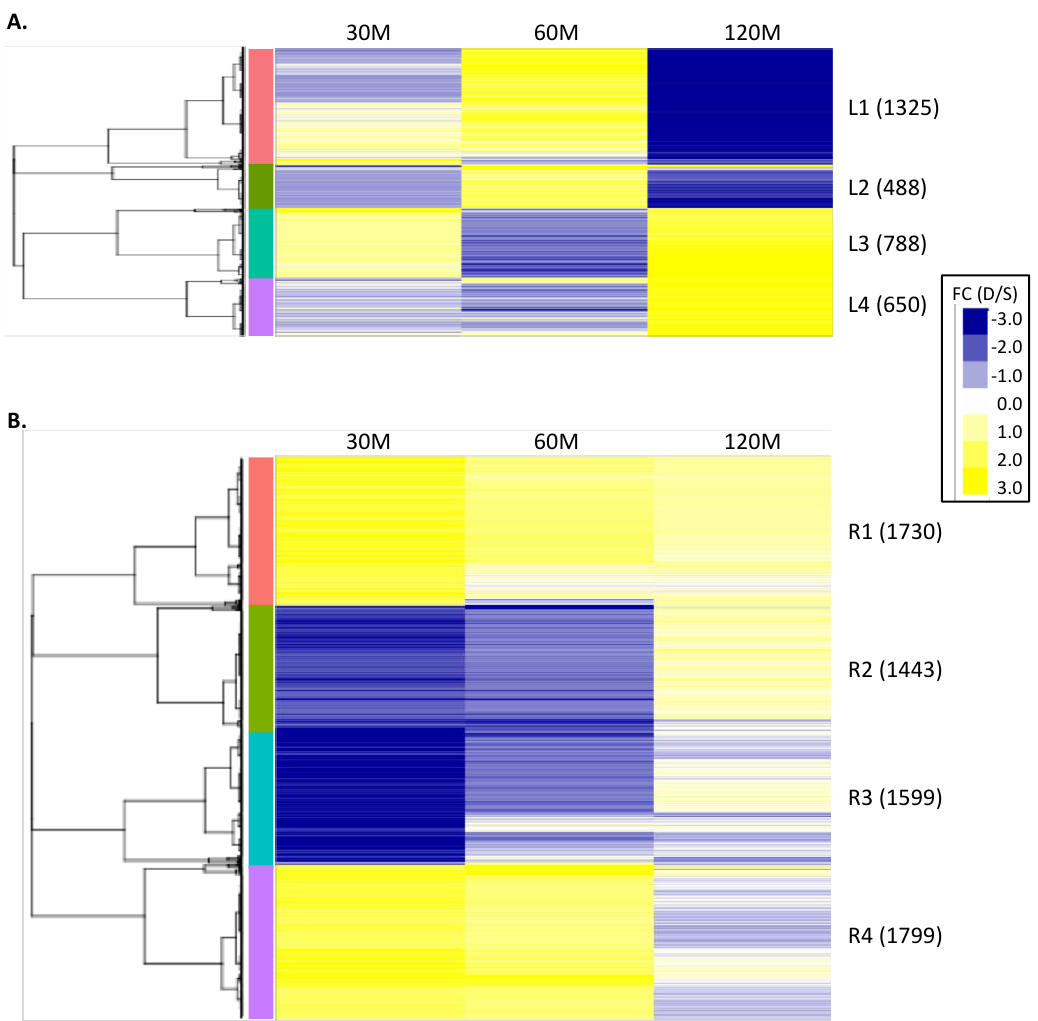
Figure 2. Iron stress responsive genes can be clustered by expression patterns across time. Hierarchical clustering of all fold change (FC) data was performed to characterize gene expression changes across time. Blue indicates repression and yellow indicates induction, in response to iron stress (deficient conditions/sufficient conditions) as indicated in the key. Four main clusters were indicated in leaves ( A ) and roots ( B ) across time. Total DEG number indicated in parentheses after the cluster name.